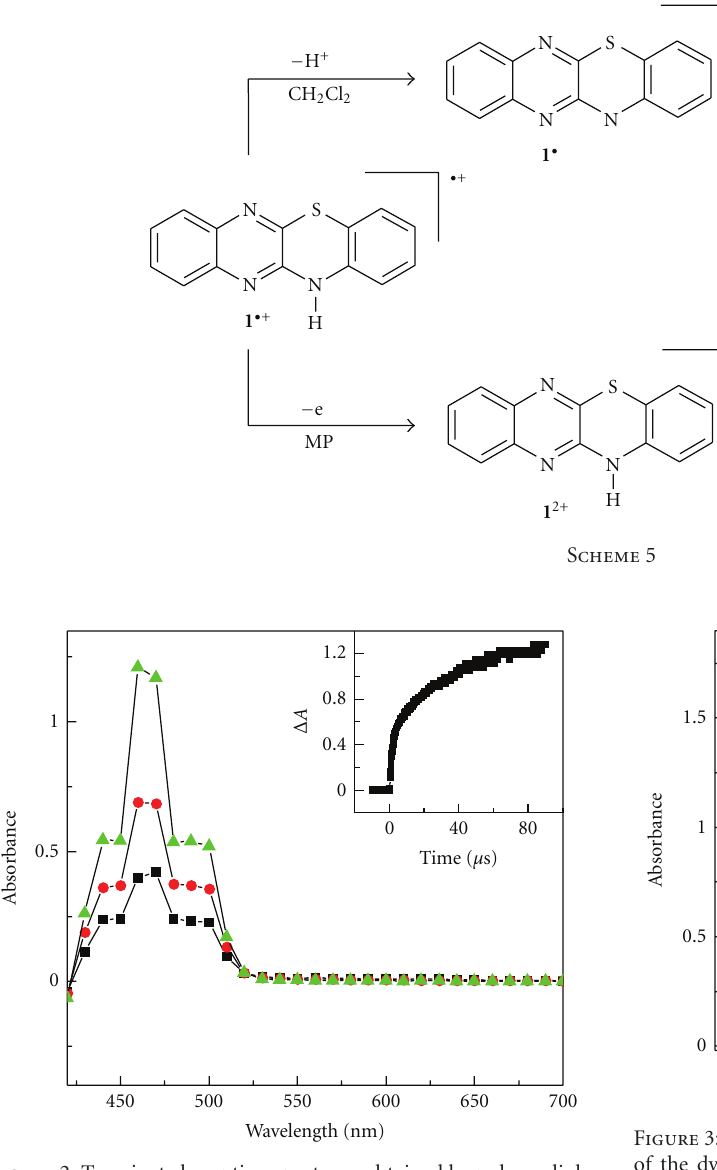
Figure 2: Transient absorption spectrum obtained by pulse radiol- ysis of 1 (0.2mM) in an oxygen saturated CH 2 Cl 2 solution. The spectrum was collected at (black square) 2 μ s, (red circle) 10 μ s, and (green triangle) 80 μ s after an electron pulse. Inset: change in absorbance at 460 nm. The sample was 1cm thick and received a radiation dose of 66 Gy.